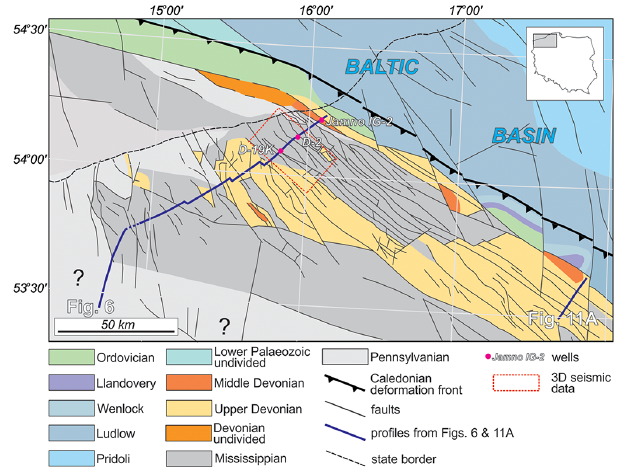
Figure 3. Geological map of NW Poland without Permian, Meso- zoic and Cenozoic (after Poprawa, 2019,